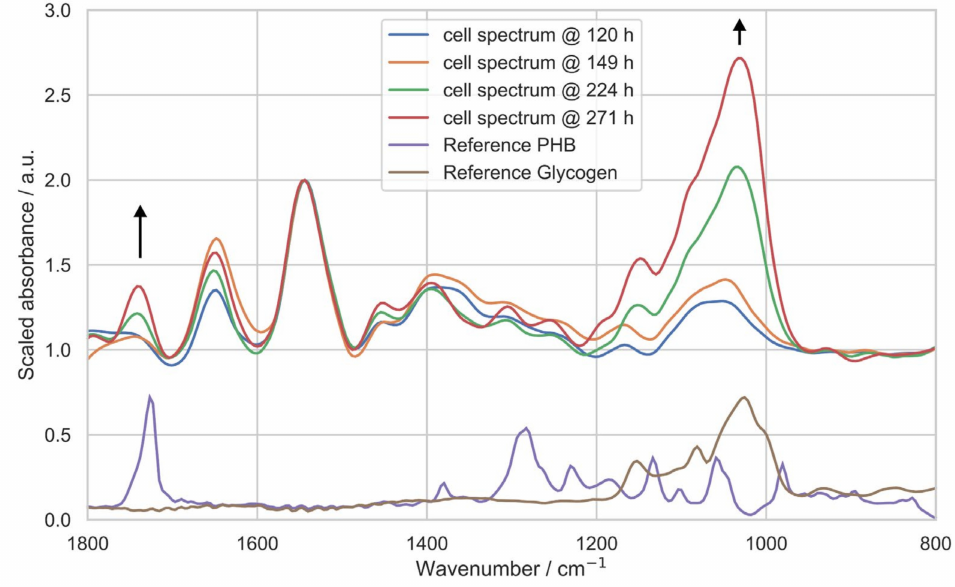
Figure 3. Top: in-line spectra of cells during different times in fermentation. PHB and glycogen bands were increasing steadily. Bottom: reference spectra of dry PHB and glycogen powder, showing approximate position of specific absorption